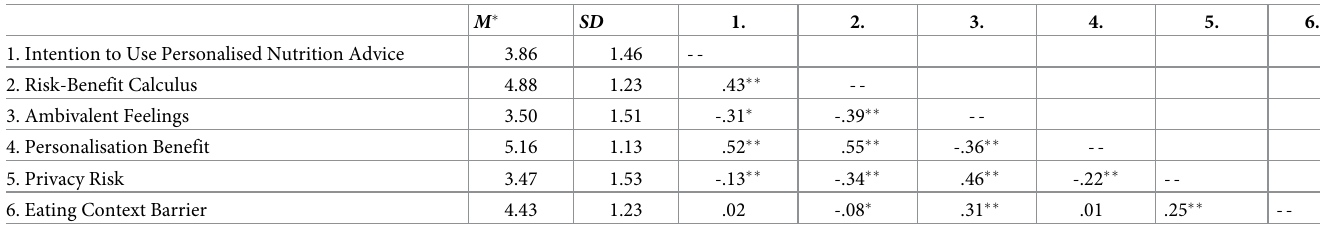
Table 3. Descriptive statistics and inter-correlations among study variables (N =